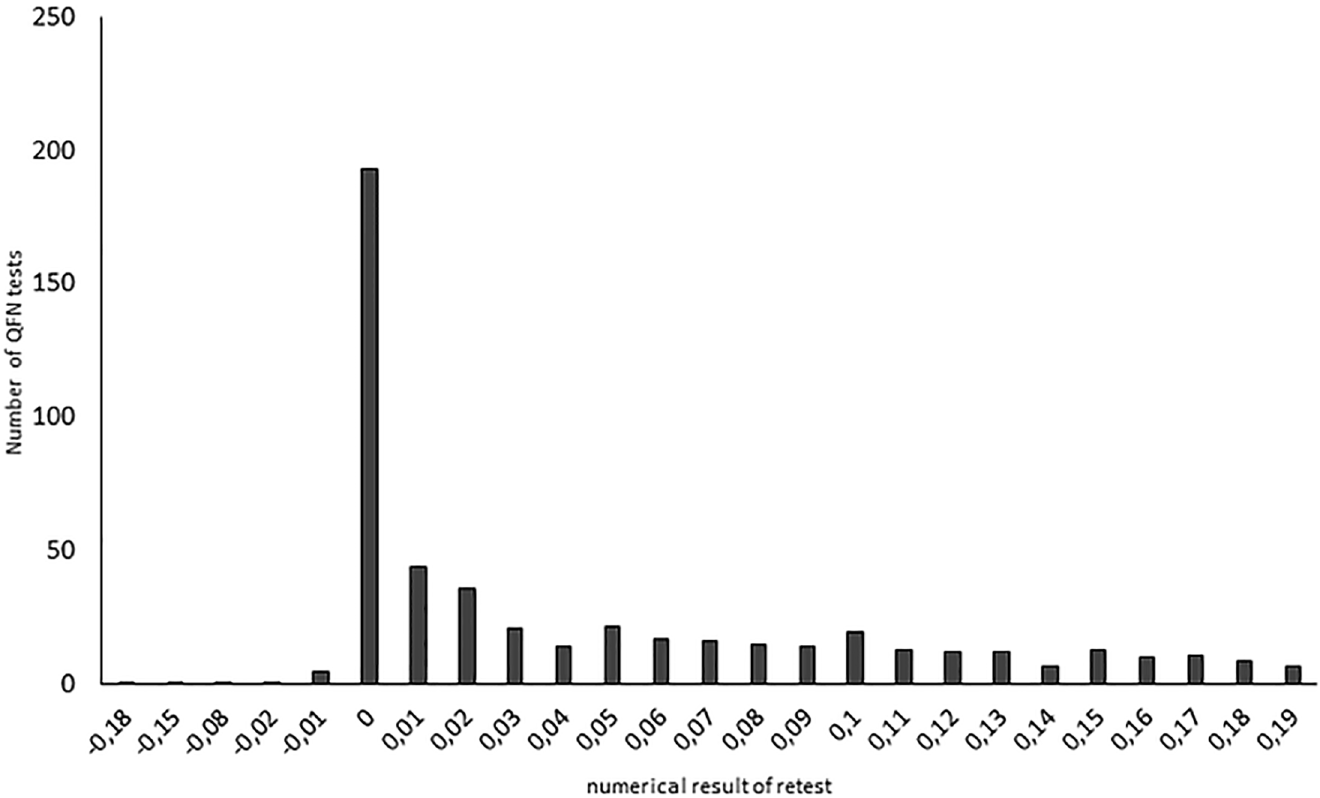
Fig 2. Distribution of numerical results of negative ( < 0.20IU/ml) results from a follow-up sample when the initial test were in the borderline range (0.2–0.99 IU/ml, n = 515).